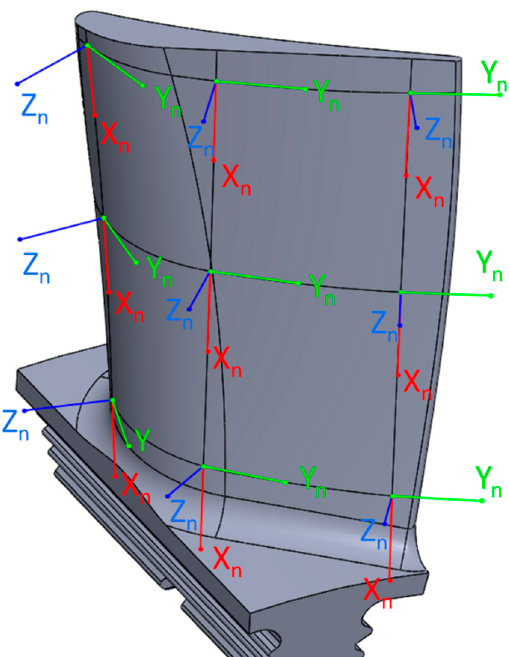
Figure 5. Schematic diagram of measuring point on the blade in the local coordinate systems.